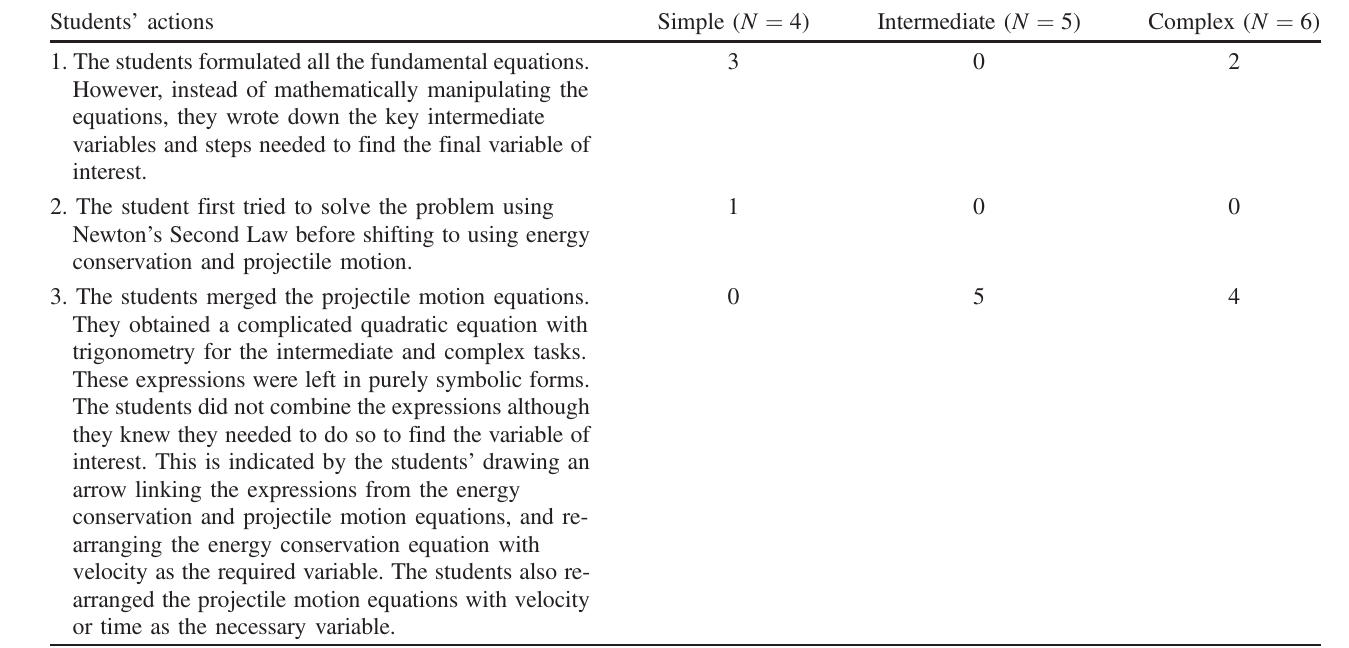
TABLE III. Actions of those students who did not combine the equations across the three versions of the sequential synthesis task. Students ’